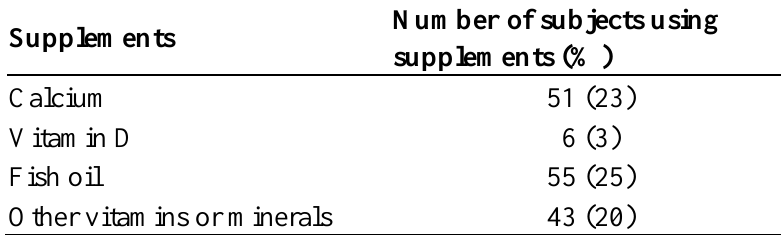
Table 4. Prevalence of supplements use in study participants (n =